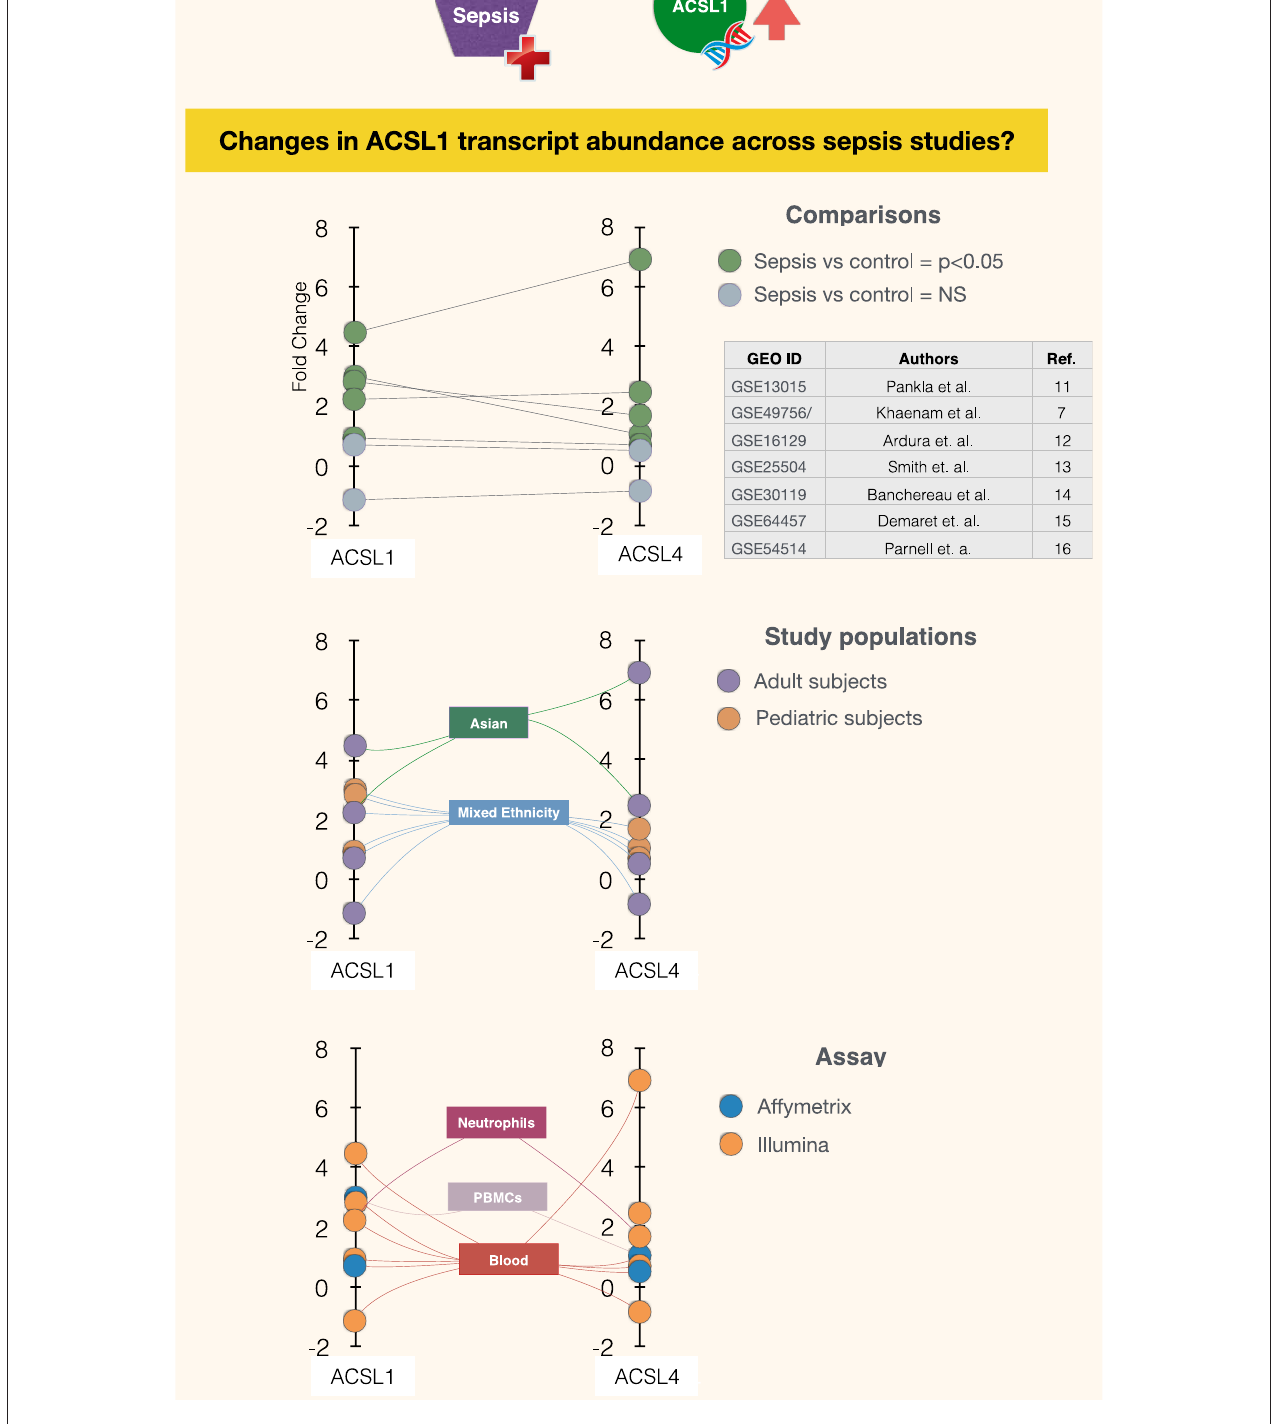
FIGURE 2 | Abundance of ACSL1 and ACSL4 transcripts is significantly increased in the context of sepsis in five out of seven datasets. Fold changes in abundance of ACSL1 and ACSL4 is shown in sepsis vs. control groups across multiple datasets (7, 11–16). Each spot represents a single dataset, except for GSE49756/7 which shows averaged values for the GSE49756 and GSE49757 series and that also comprises GSE49755 ( Figure 1 ). The position of the spot on the vertical axis indicates the corresponding fold change in abundance of ACSL1 (left) and ACSL4 (right). Spots are connected to dataset attributes (metadata). On the top panel attributes relevant to the group comparisons that were performed are shown (indicating which groups are being compared and whether increase in ACSLs abundance are statistically significant). On the middle and bottom panels additional attributes that describe the study populations and assays are shown.